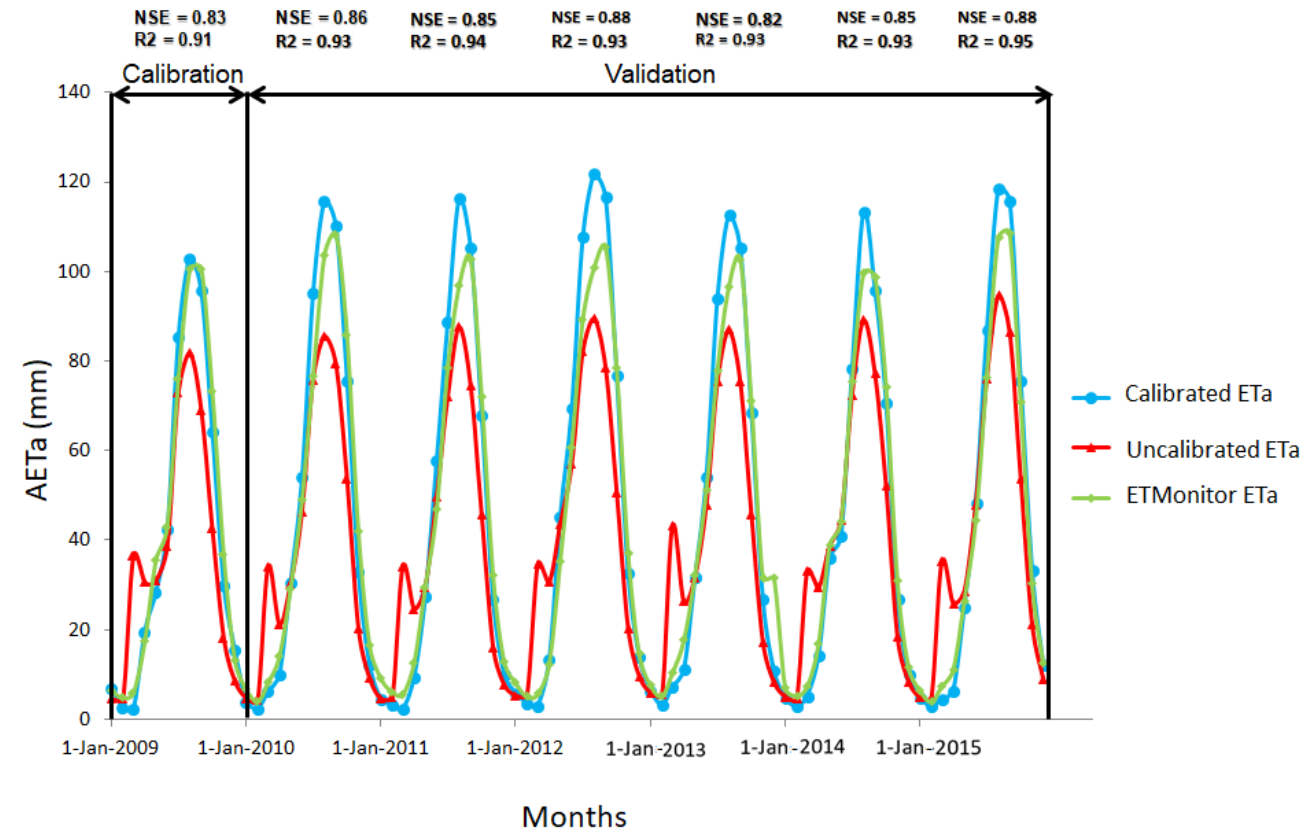
Figure 6. Time series of monthly uncalibrated and calibrated ETa simulated by the SWAT and ETa from ETMonitor in 2009–2015 in the study area in the Lake Chad Basin.